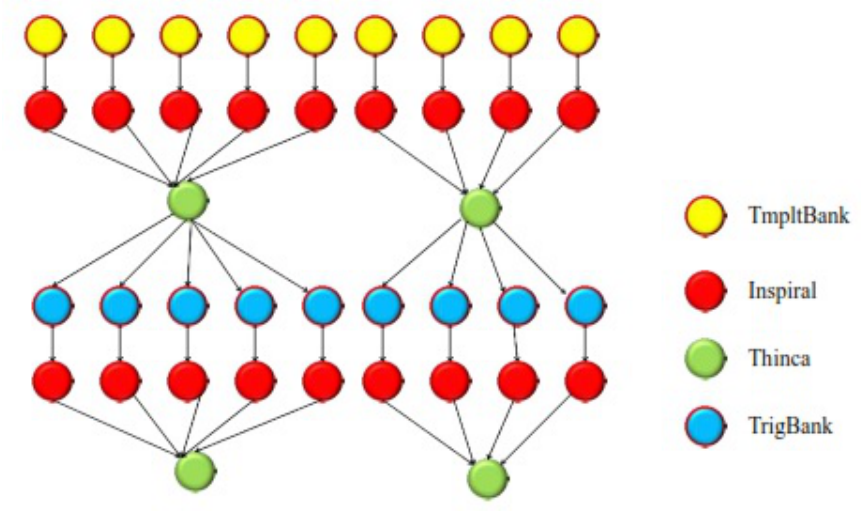
Figure 7. Inspiral workflow.